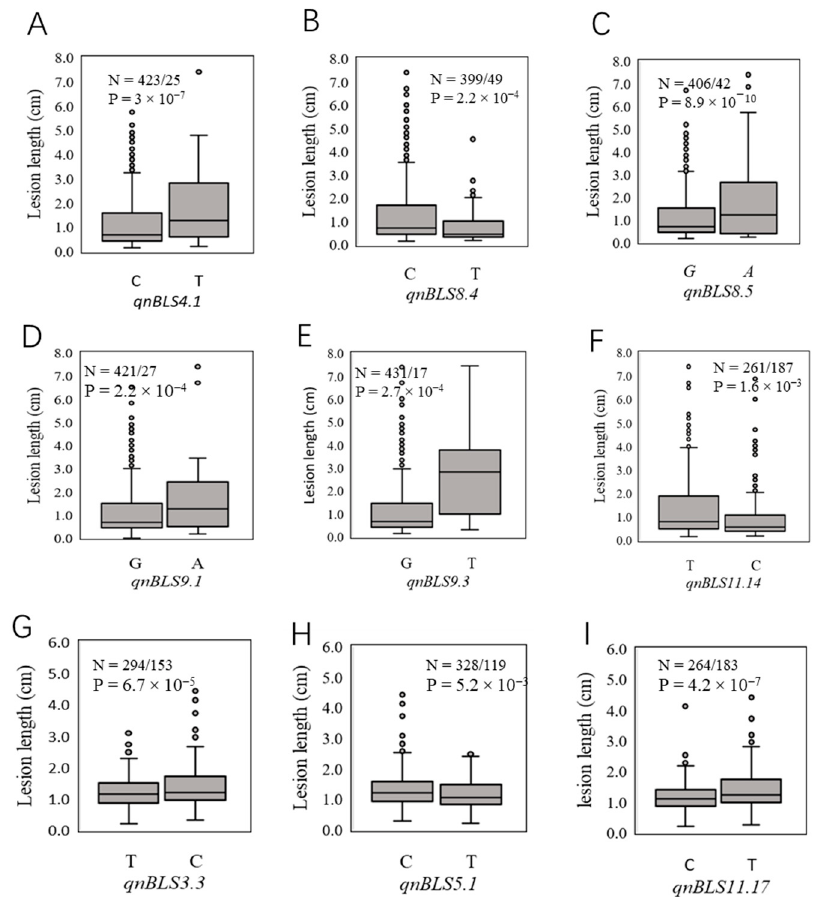
Figure 5. Boxplot for validating 9 selected QTNs ( A – I ). For each QTN, the population was divided into two groups ac- cording to allele types (N = Reference allele/SNP allele). The X-axis presented the two alleles for each QTN, while the Y- axis presented the lesion length. A t-test was used to measure the phenotypic difference of the haplotypes, and a p -value is shown at the top of the